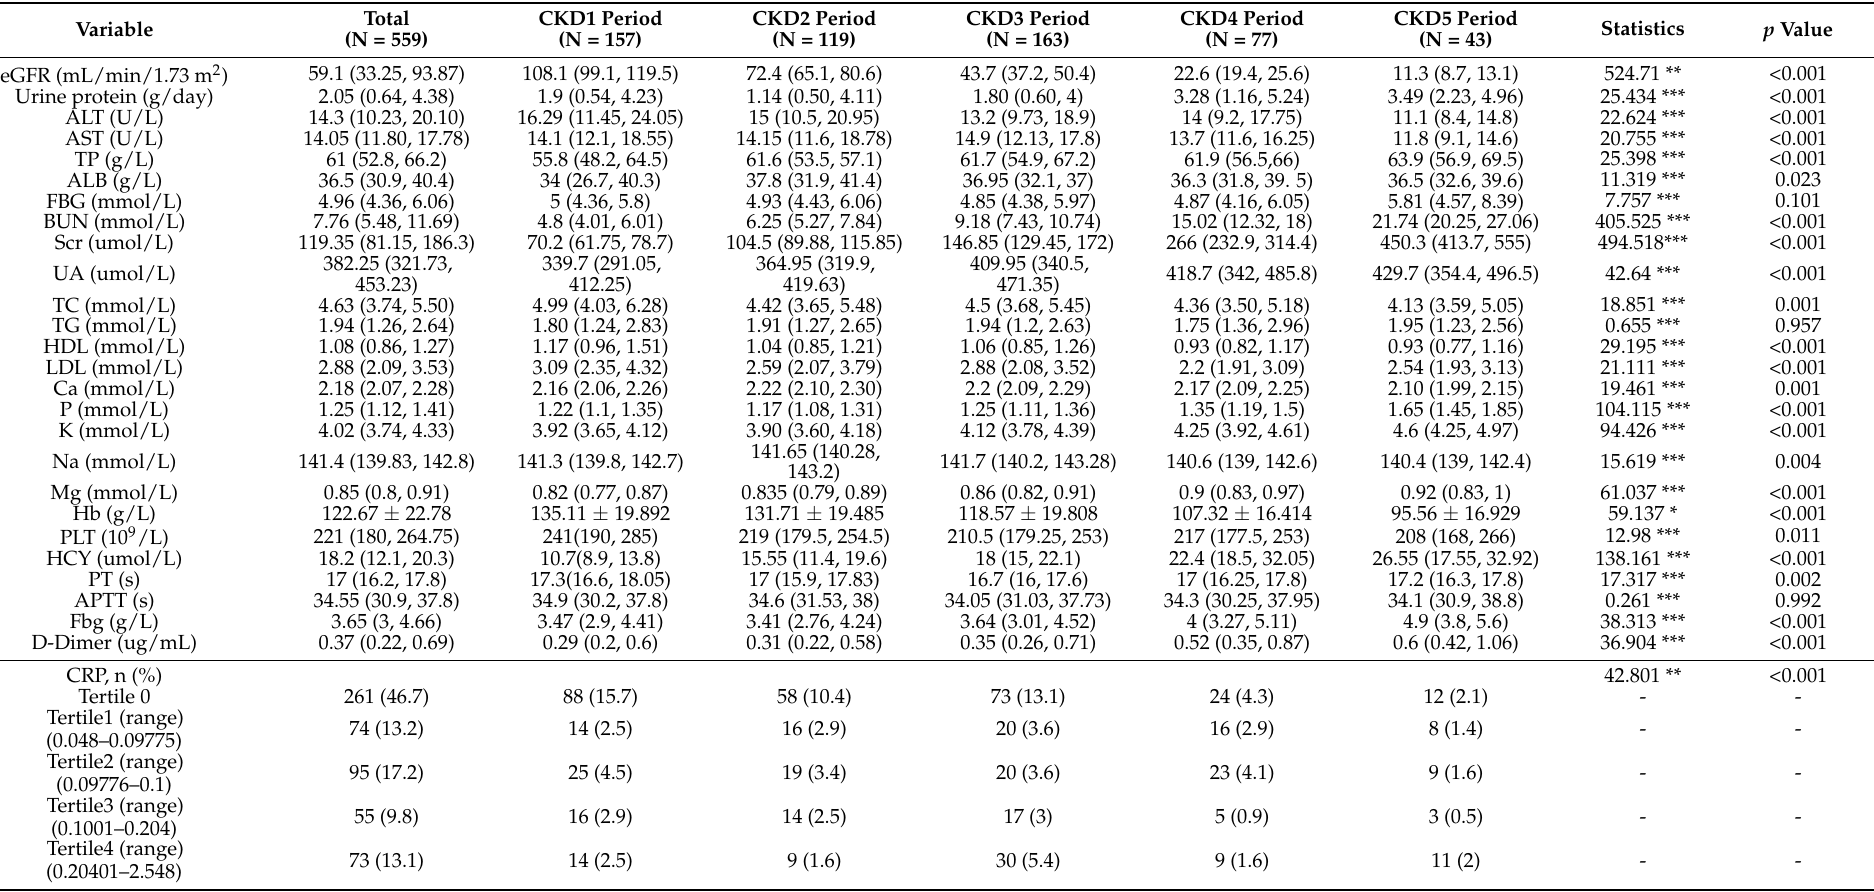
Table 2. Clinical characteristics of the